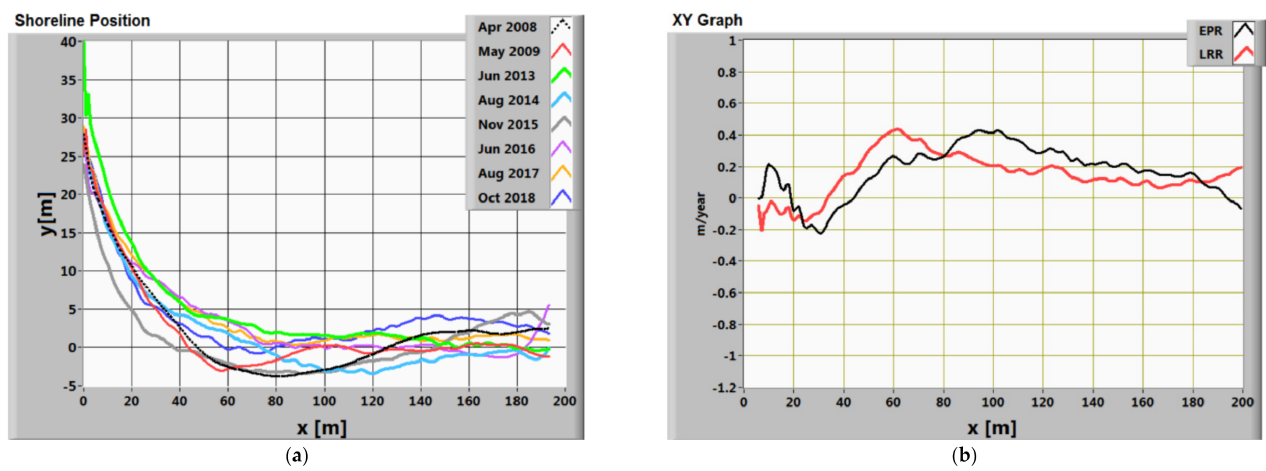
Figure 16. ( a ) y(x,t) coordinates of shorelines over time; ( b ) EPR (black line) and LRR (red line). The Linear Regression Rate (LRR) and the End Point Rate (EPR) have been used as indicators of the rate of shoreline change. LRR corresponds to the slope of a least-square straight-line, fitted through the shoreline positions at the various available times; EPR, takes into account exclusively shoreline positions at the first and the last years concerned and represents shoreline movement during that